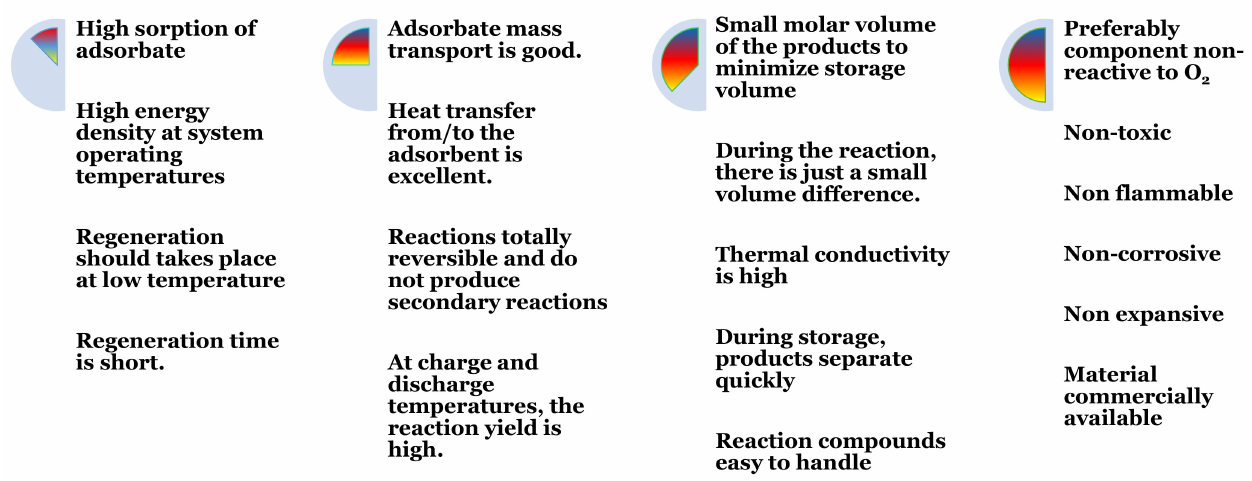
Figure 7. Criteria for selecting appropriate sorption